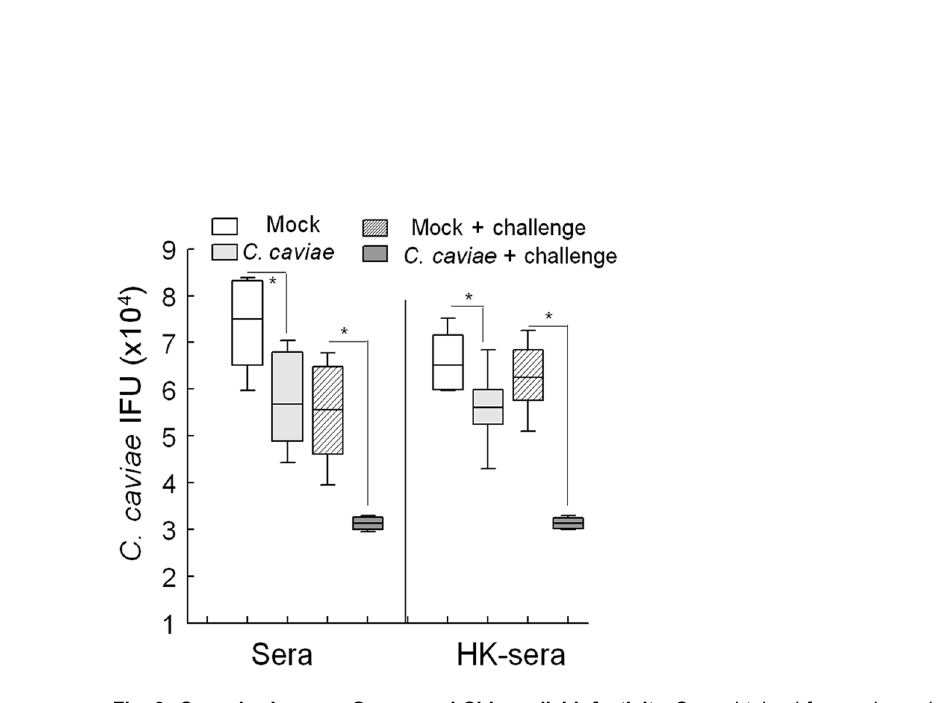
Fig. 3. C. caviae Immune Serum and Chlamydial Infectivity. Sera obtained from guinea pigs (n 5 5 per group) 30 days post vaccination with C. caviae or mock (PBS) or 15 days after challenge ( + challenge) were heat-inactivated (HK) at 56 ˚ C for 30 min or left untreated and diluted 1:25 in DMEM before addition into 96 well plate. Sera from each animal was incubated with C. caviae (2 6 10 4 IFU) for 1 hr in a shaking incubator, then sera/bacterial mixtures were added to HeLa cells (0.01 MOI) for bacterial enumeration. Bacterial numbers for each group were presented as a box-and-whisker plot. * p ,